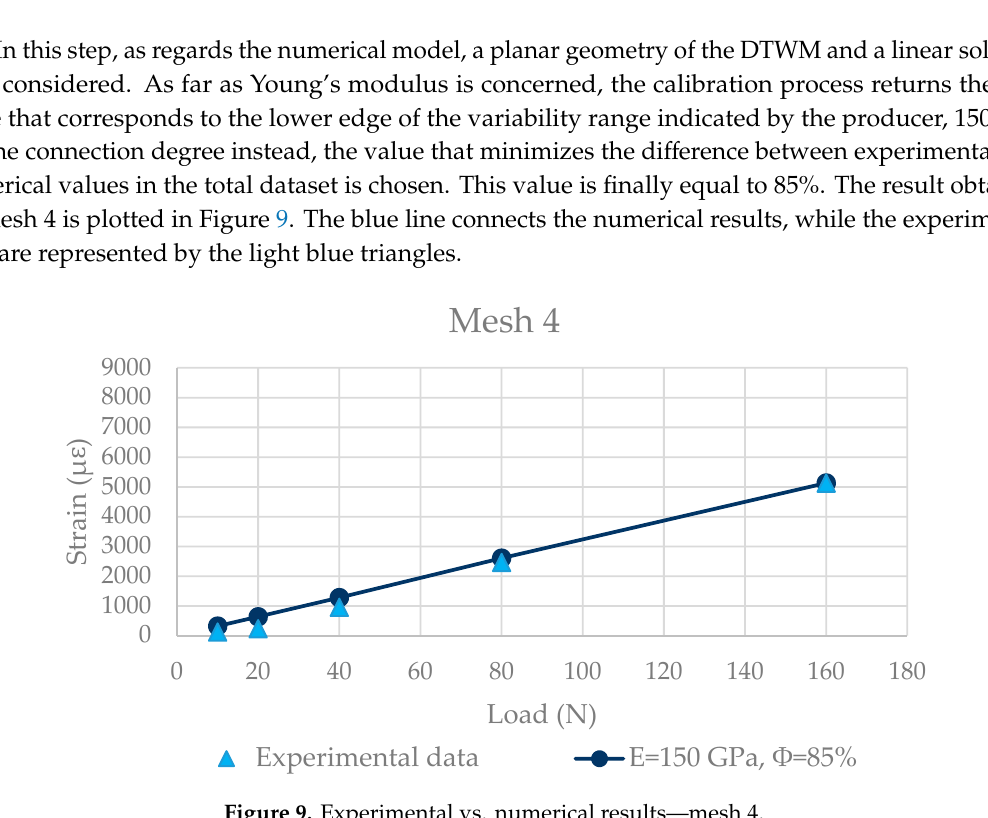
Figure 9. Experimental vs. numerical results—mesh 4.